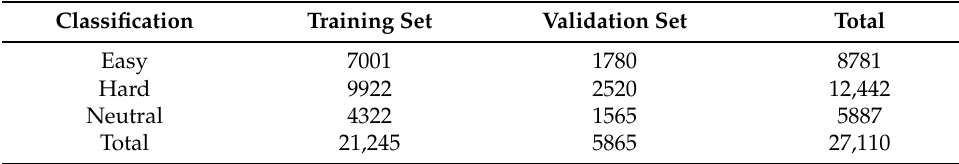
Table 2. Dataset (size 48 × 48) used for the experiments.